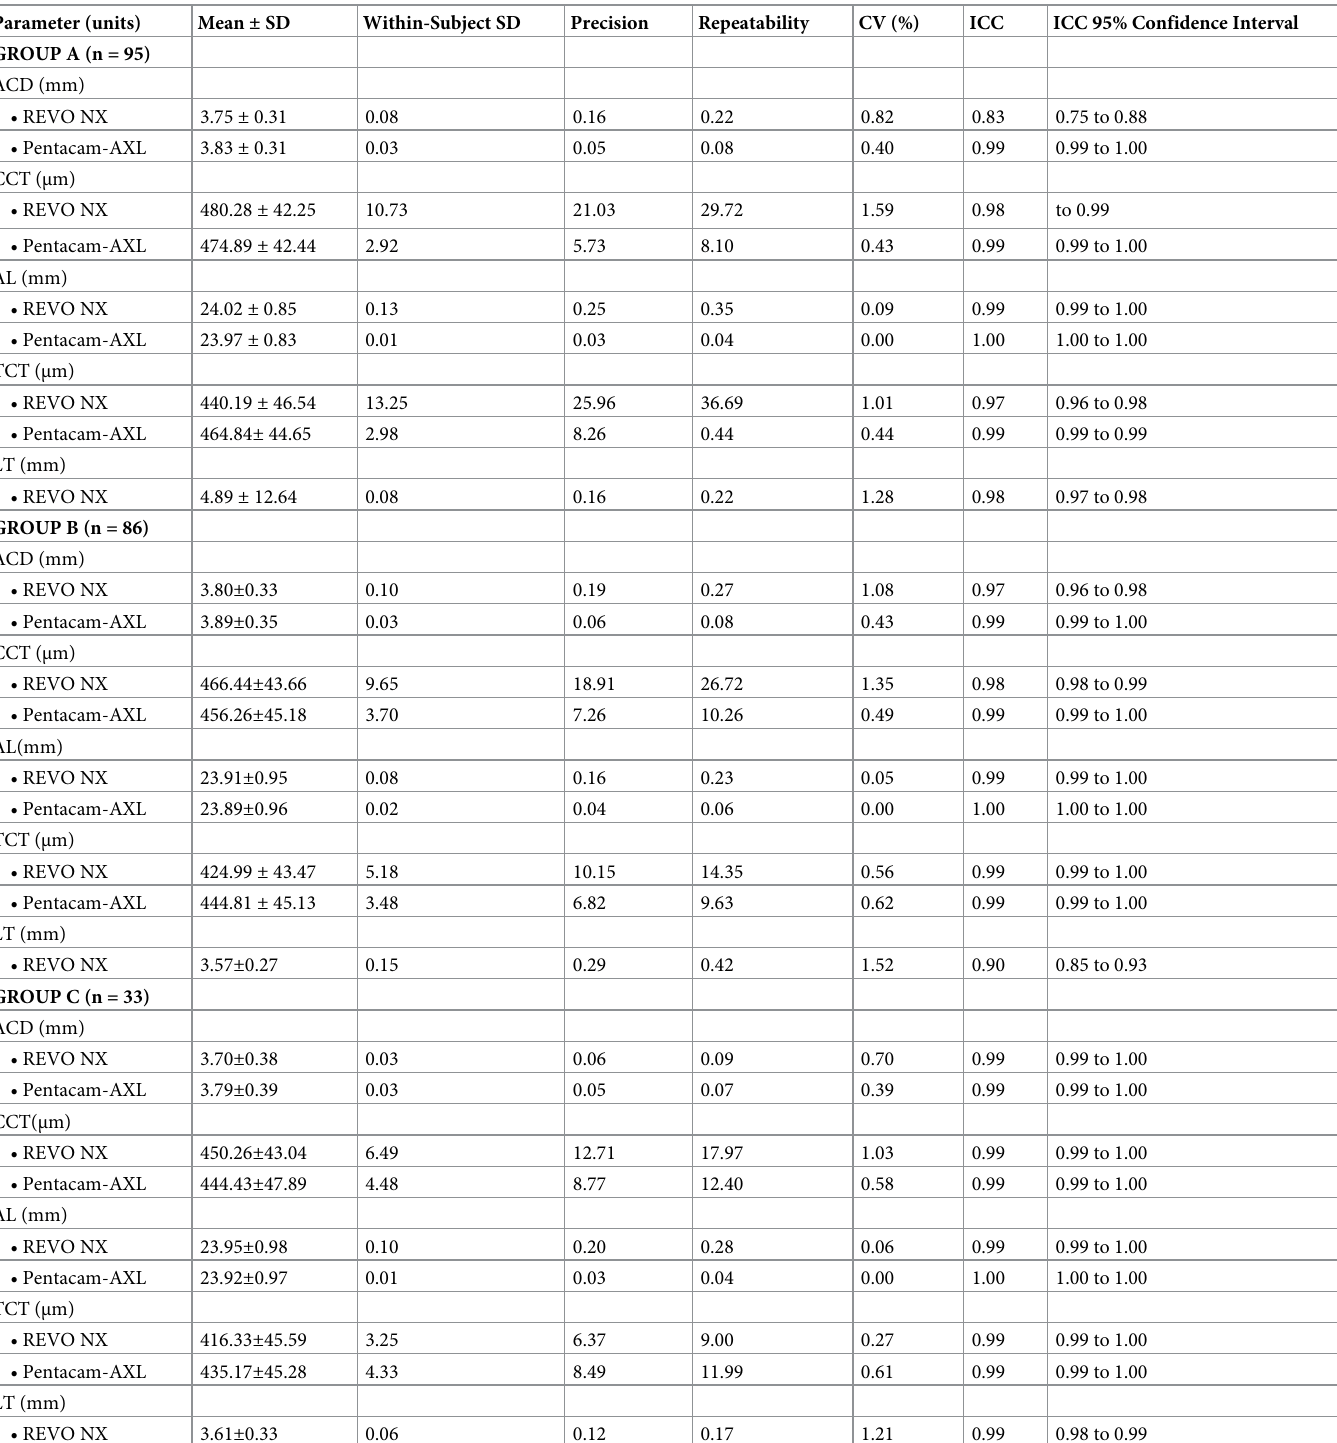
Table 2. S w , precision, repeatability, CV, and ICC (95% confidence interval). Parameter